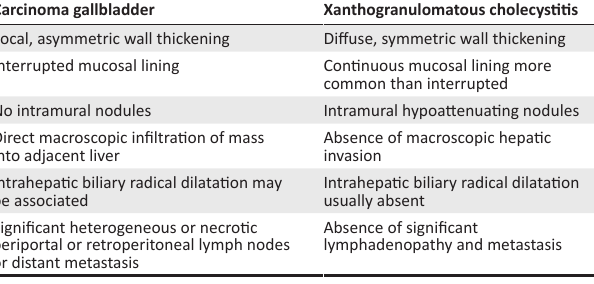
TABLE 1: Differences in imaging features of carcinoma gallbladder and xanthogranulomatous cholecystitis. Carcinoma gallbladder Xanthogranulomatous cholecystitis Focal, asymmetric wall thickening Diffuse, symmetric wall thickening Interrupted mucosal